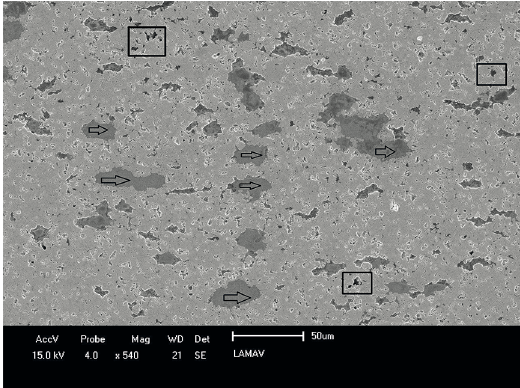
Figure 2. Structure of alloy REF. Elongated and aligned Co particles according to the pressing direction and pores (in squares) are